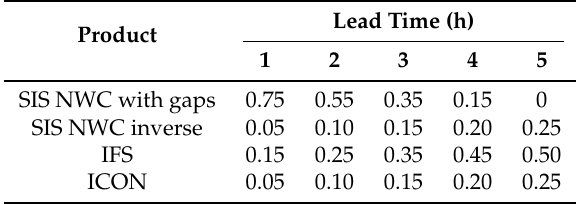
Table 3. Lagrangian weights for the blending with ANAKLIM++ for the nowcasting with gaps and its corresponding inverse layer (only content of gaps) and for the NWP models IFS (integrated forecasting system) and ICON (icosahedral non-hydrostatic model)